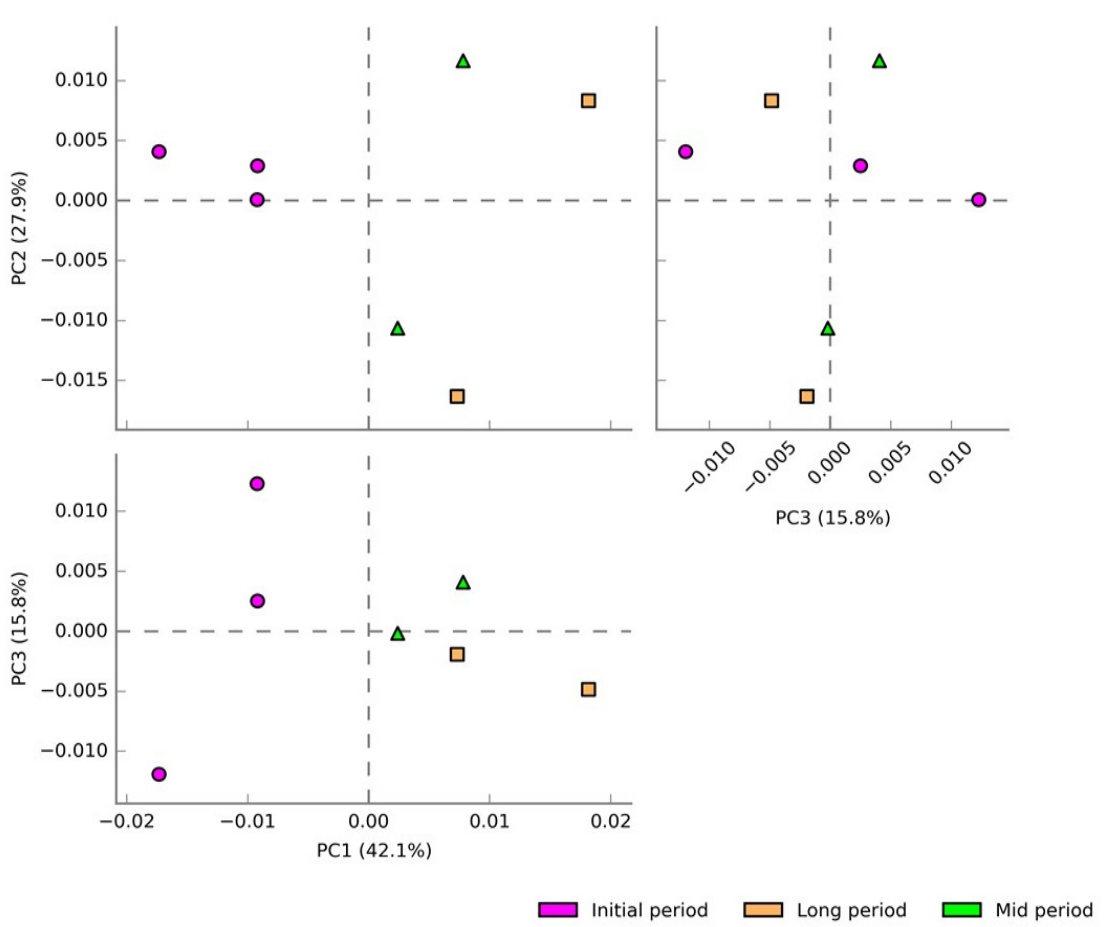
Figure 6. PCA plots showing the grouping of samples based on their predicted metabolic functions collected at various time intervals. The distinct variation indicated their uniqueness in the predicted potential metabolic functions.